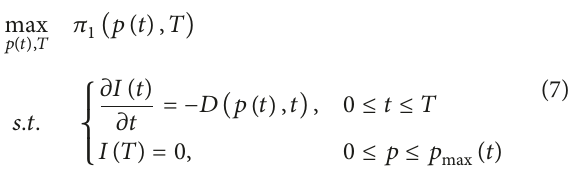
= 𝑐 ∫ 𝑇 𝐷(𝑝(𝑡), 𝑡)𝑑𝑡 + 𝐴 2 0